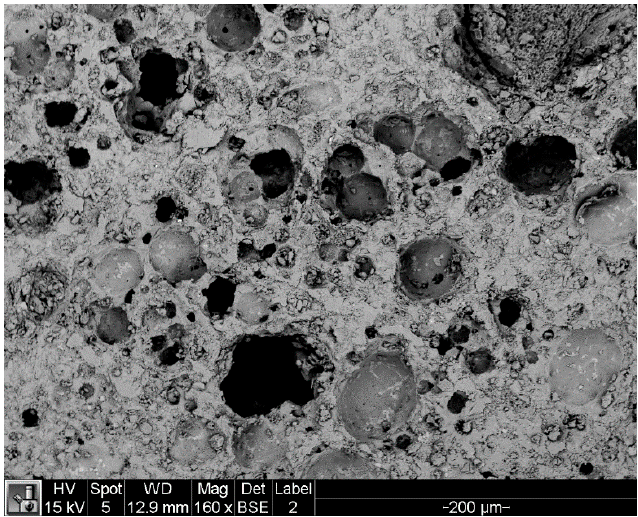
Figure 8. SEM image of LWA in backscattered mode.